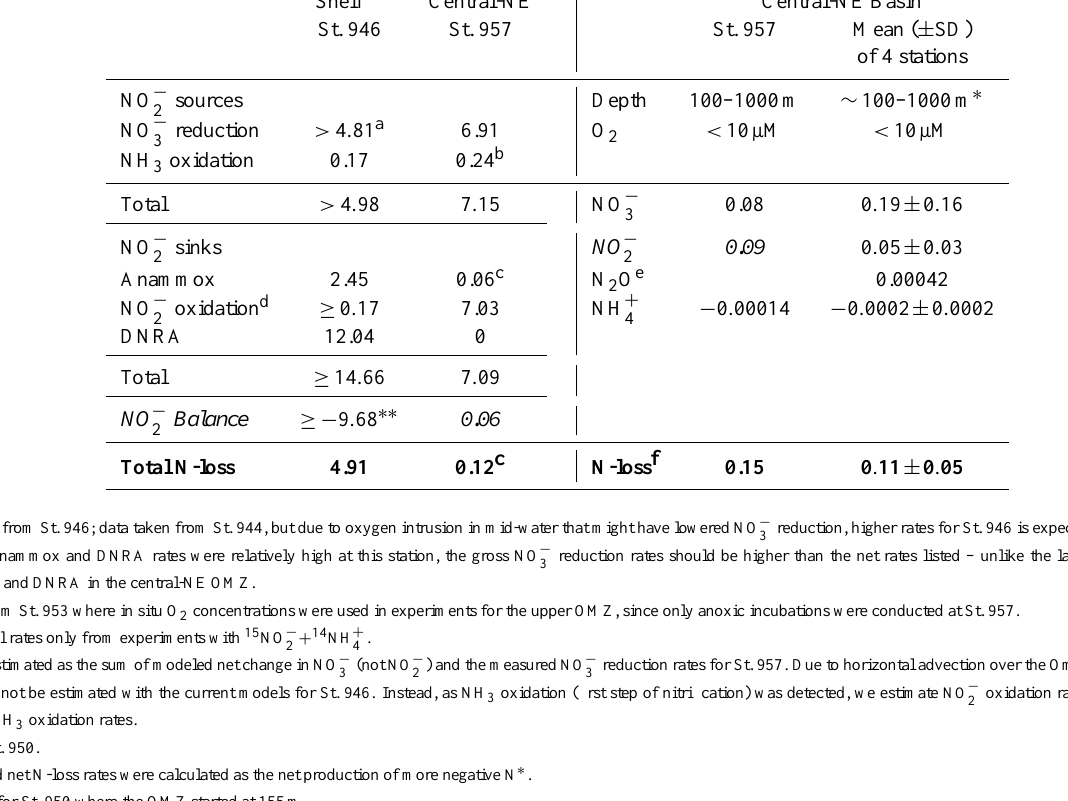
sources and sinks in the Arabian Sea OMZ (O 2 < 10µM) over the Omani Shelf vs. 2